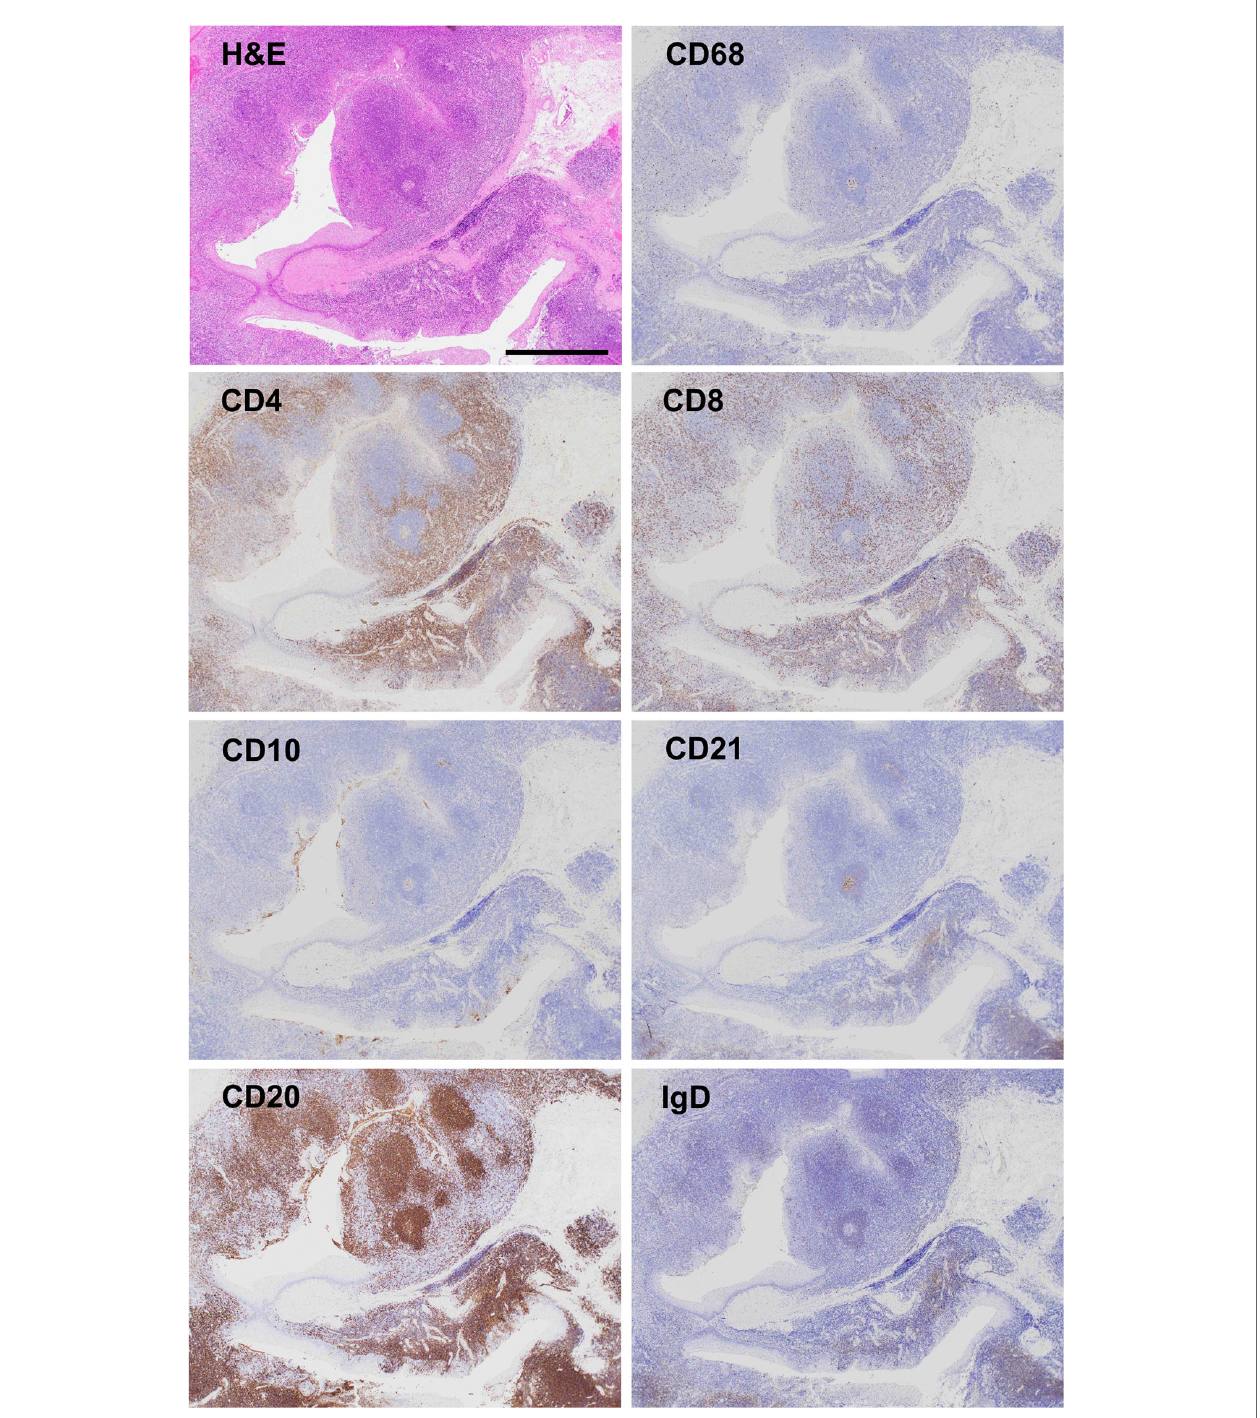
FIGURE 2 | Micrographs of resected tonsil sections Hematoxylin and eosin (H&E) staining showed chronic tonsillitis with activated macrophages based on CD68 positivity. Immunostaining for CD4 and CD8 displayed T cell accumulation in the opposite sides of blind crypts. Most lymphoid follicles (CD20, a marker for follicular B cell) consisted of primary follicles with poorly developed germinal centers (CD10, a marker for germinal center B cells; CD21, a marker for germinal center dendritic cells), rare secondary follicle formation, and an expanded mantle zone (IgD, a marker for mantle zone B cells), which are characteristic pathological features of chronic tonsillitis associated with IgA nephritis but not chronic tonsillitis without IgA nephritis. Scale bar, 1